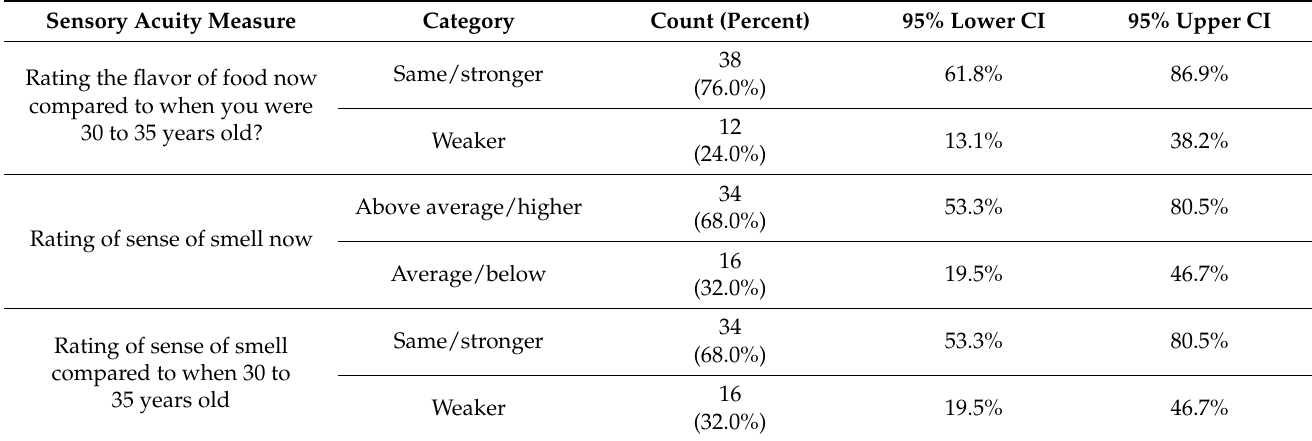
Table 5. Subjective Sensory